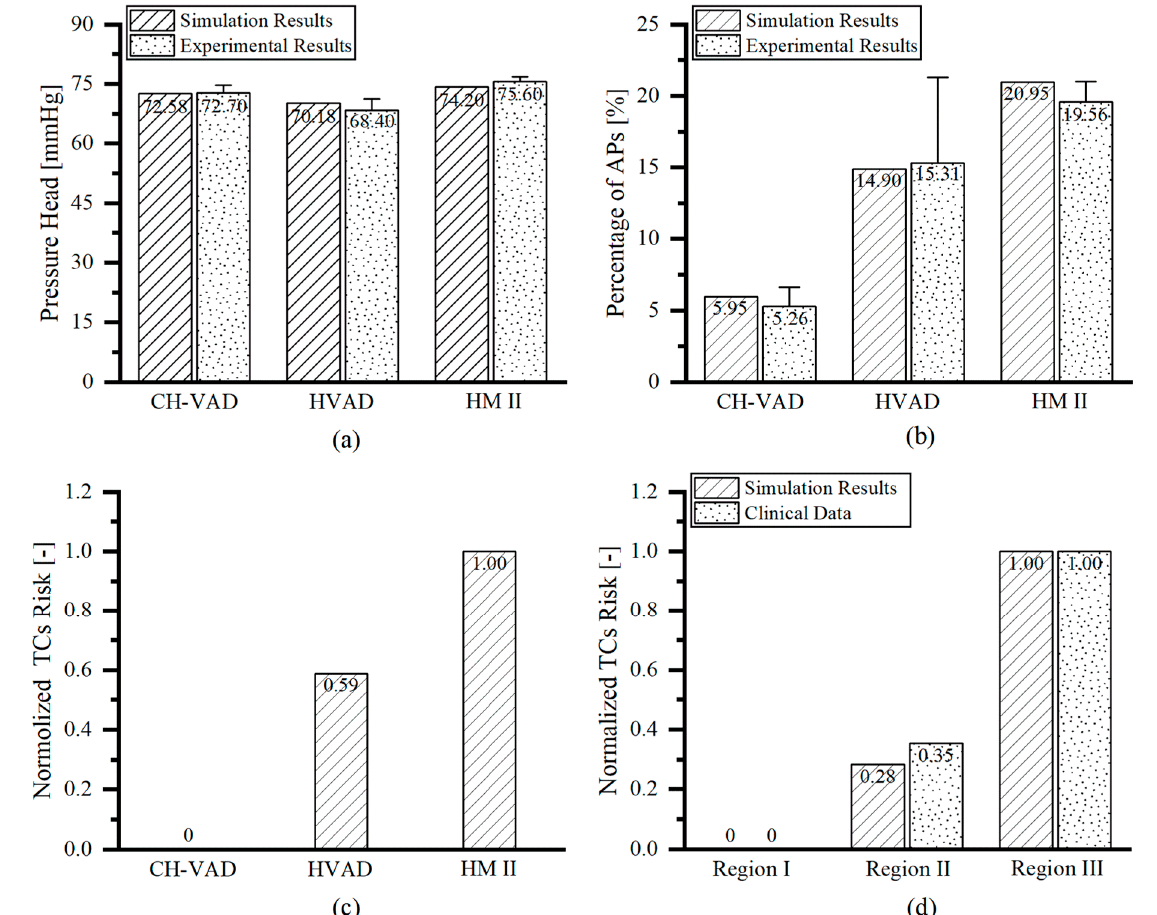
Figure 5. VAD hemocompatibility assessment and comparison for CH-VAD, HVAD and HMII : ( a ) Pressure head (correlation coefficient with experimental results [26] r 2 = 0.999); ( b ) Platelet activation ratio (correlation coefficient with experimental results [26] r 2 = 0.984); ( c ) Thrombotic risk; and ( d ) Assessment of thrombotic risk in different regions of HMII (correlation coefficient with clinical data [53] r 2 = 0.994).